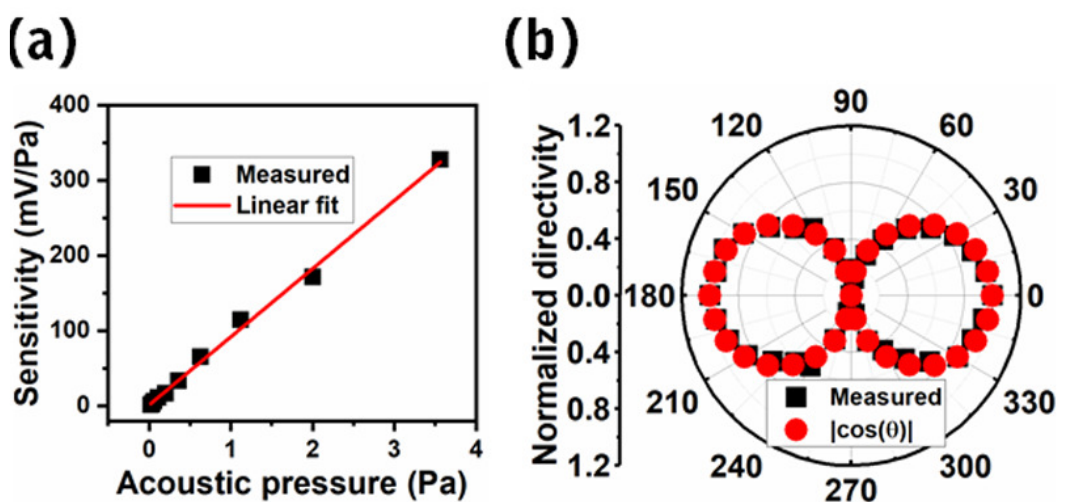
Figure 9. Experimental results at 1 kHz frequency: ( a ) acoustic sensitivity of the microphone when varying the acoustic pressure from 0.02 Pa to 3.56 Pa at 1 kHz frequency, and ( b ) directivity measurements at 1 kHz frequency and 1 Pa of sound